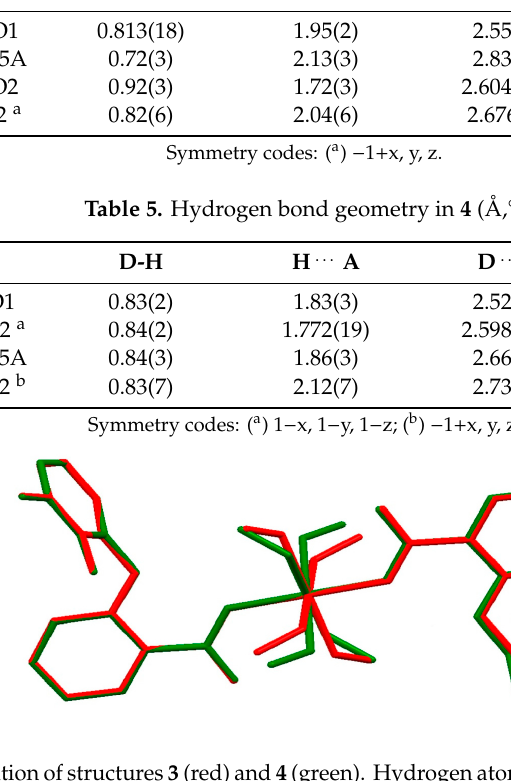
Figure 3. Superposition of structures 3 (red) and 4 (green). Hydrogen atoms and methanol O5 molecules in the outer coordination sphere are omitted for clarity. Table 4 . Hydrogen bond geometry in 3 (Å,°).